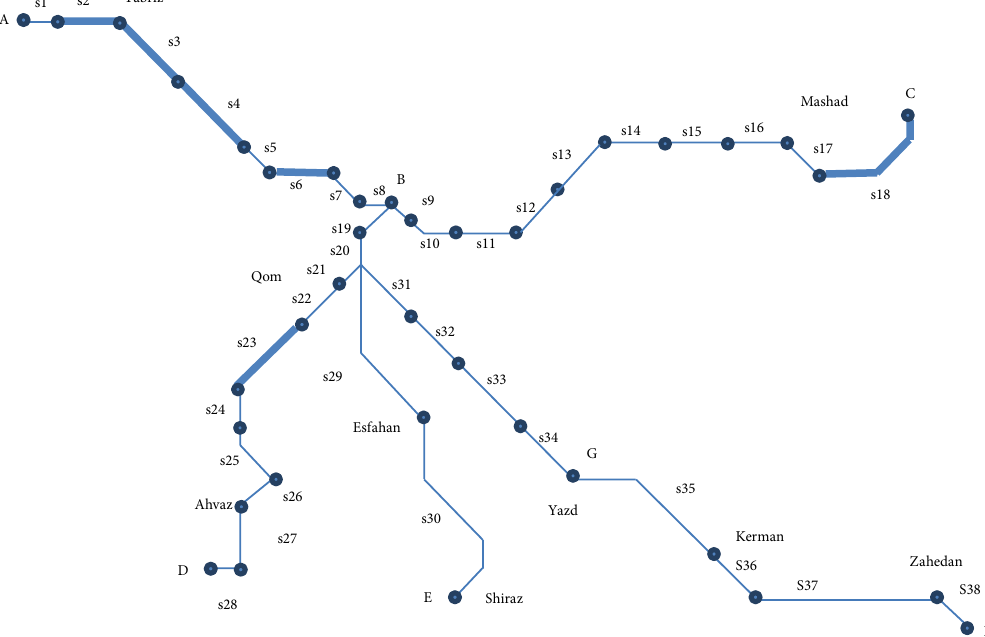
Fig. 3. Expanded network (unequal flow)